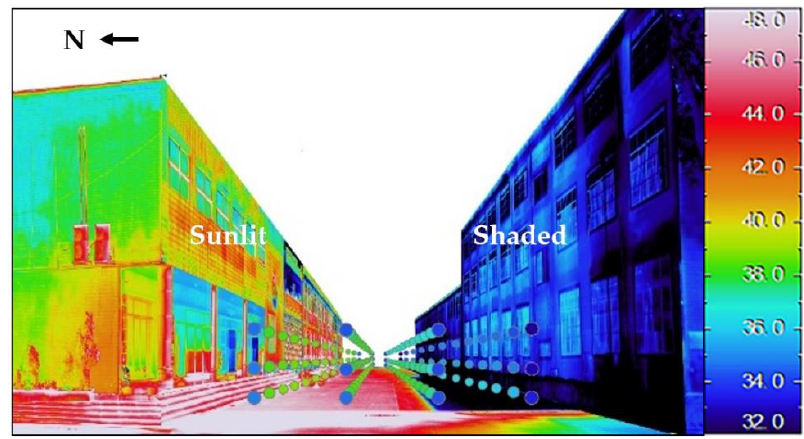
Figure 8. Spatial distribution of MRT values in the pedestrian space between the teaching buildings.